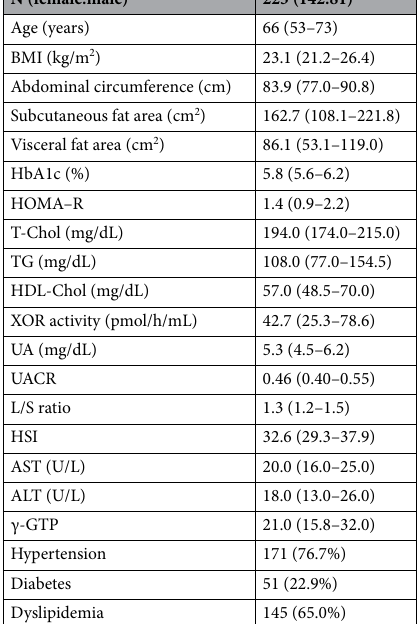
Table 1. Participant characteristics. The results are presented as median (interquartile range). BMI, body mass index; HbA1c, hemoglobin A1c; HOMA-R, homeostasis model assessment ratio; T-Chol, total-cholesterol; TG, triglycerides; HDL-Chol, high-density lipoprotein-cholesterol; XOR, xanthine oxidoreductase; UA, uric acid; UACR, urine uric acid to creatinine ratio; L/S, liver-to-spleen; HSI, hepatic steatosis index; AST, aspartate transaminase; ALT, alanine transaminase: γ-GTP, γ-glutamyl